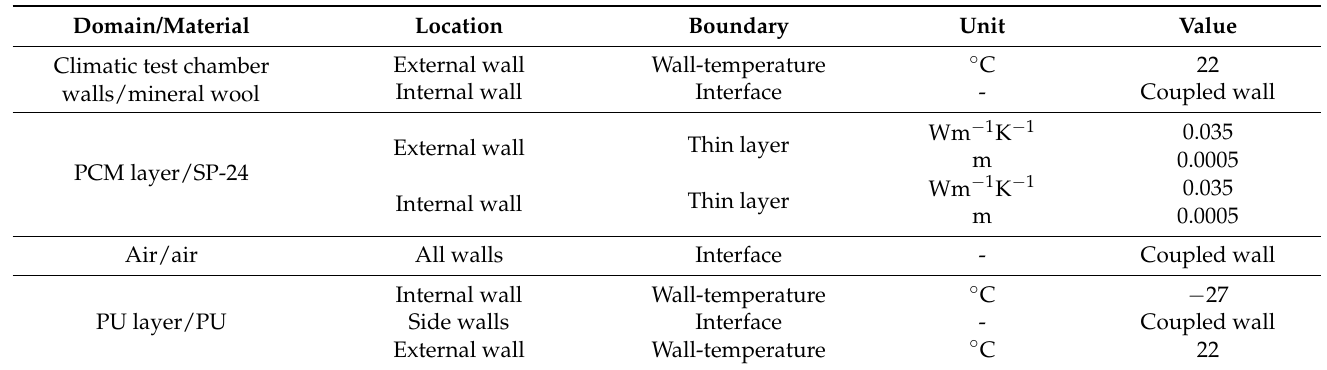
Table 3. Boundary conditions employed during calculation in stationary step.